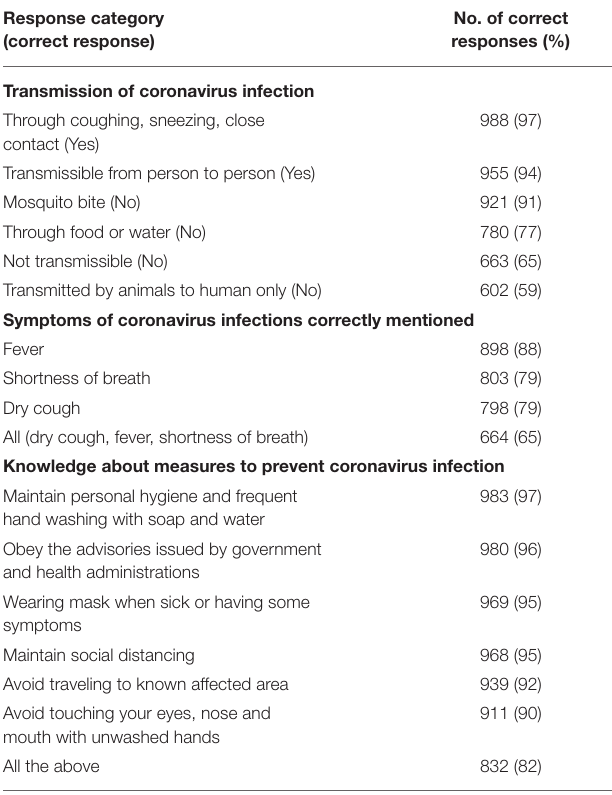
TABLE 4 | Responses of participants to attitudinal statements regarding COVID